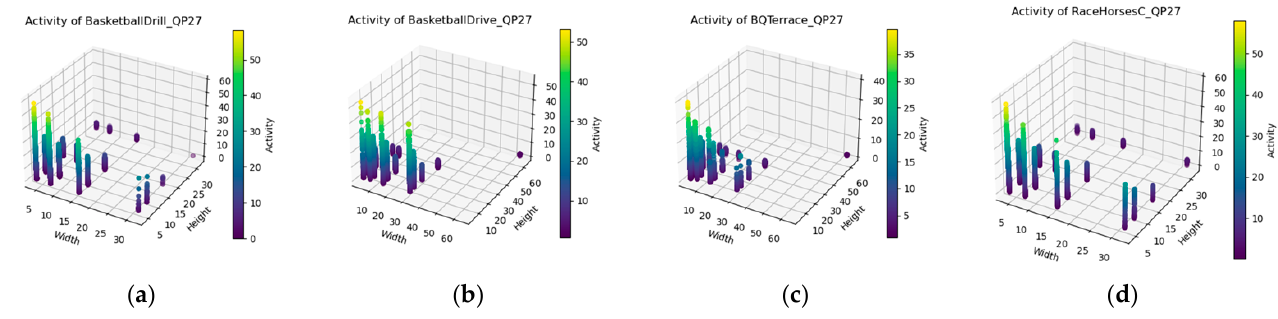
Figure 4. The activity distribution per sample according to the block size: ( a ) BasketballDrill —832 × 480; ( b ) BasketballDrive —1920 × 1080; ( c ) BQTerrace —1920 × 1080; ( d ) RaceHorsesC —832 × 480.